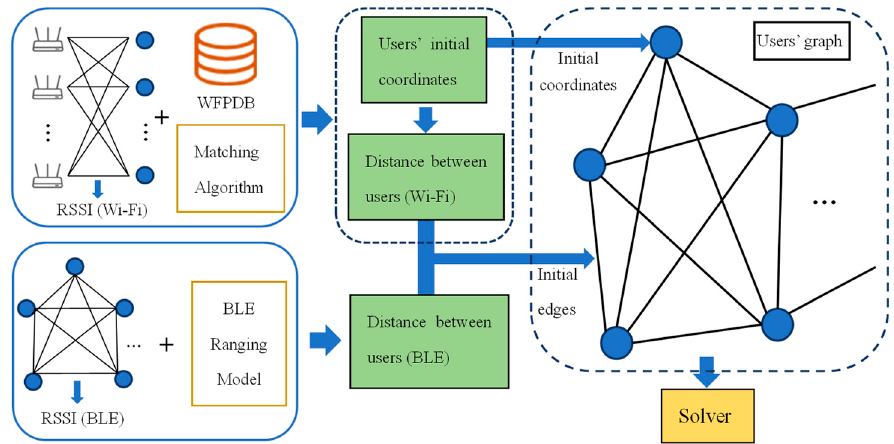
Figure 3. Construction of the proposed model.